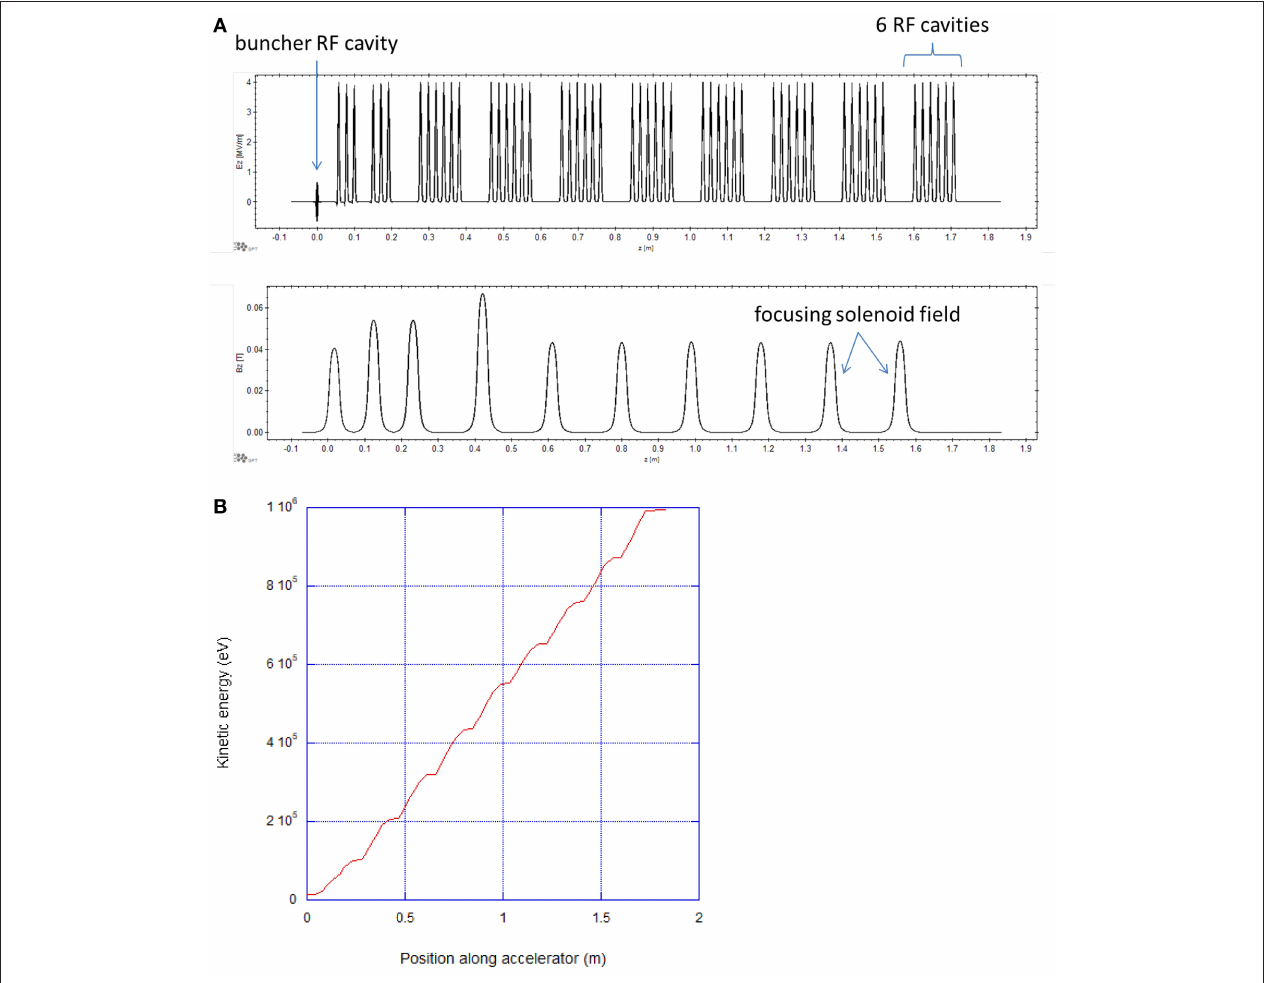
FIGURE 3 | (A) Plot of accelerating field magnitudes of individual RF cavities and focusing solenoid fields along the accelerator; (B) plot of kinetic energy in eV vs. position along the accelerator.